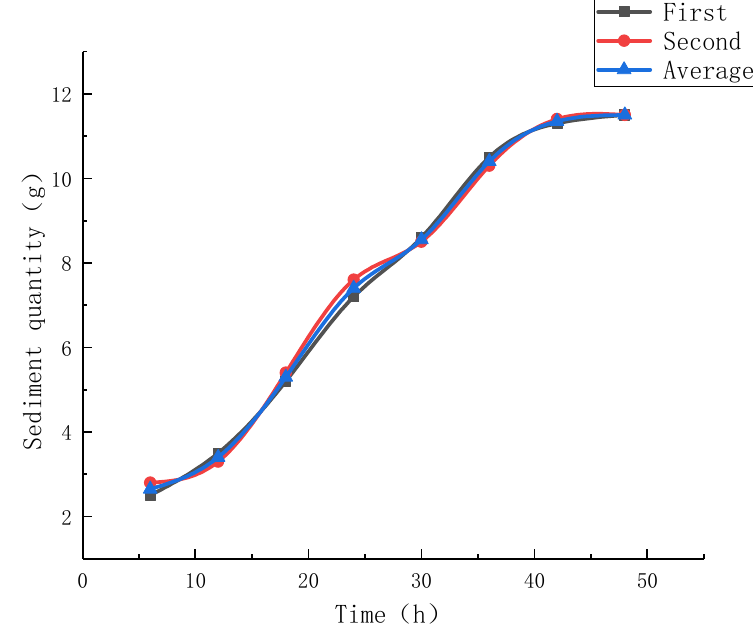
Figure 4. Sediment quality curves at the time of different depositions.